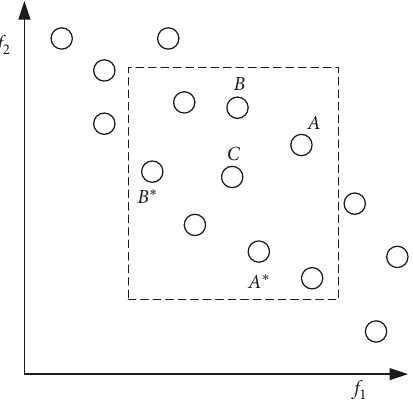
Figure 2: Illustration of motivation 2 : given a solution C , whose neighbors are in the dash rectangle. It is clear that it has a higher chance to generate a better child solution if A ∗ and B ∗ are selected as parents, compared to A and B